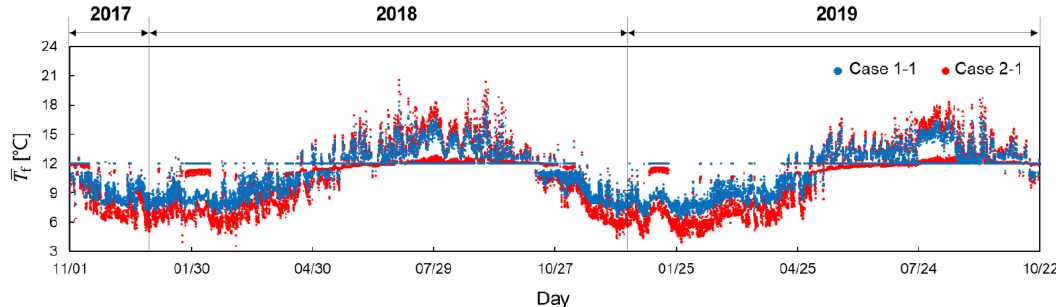
Figure 16. Average temperature variation of the circulating fluid; comparison between the proposed method and the conventional TRT analysis method.